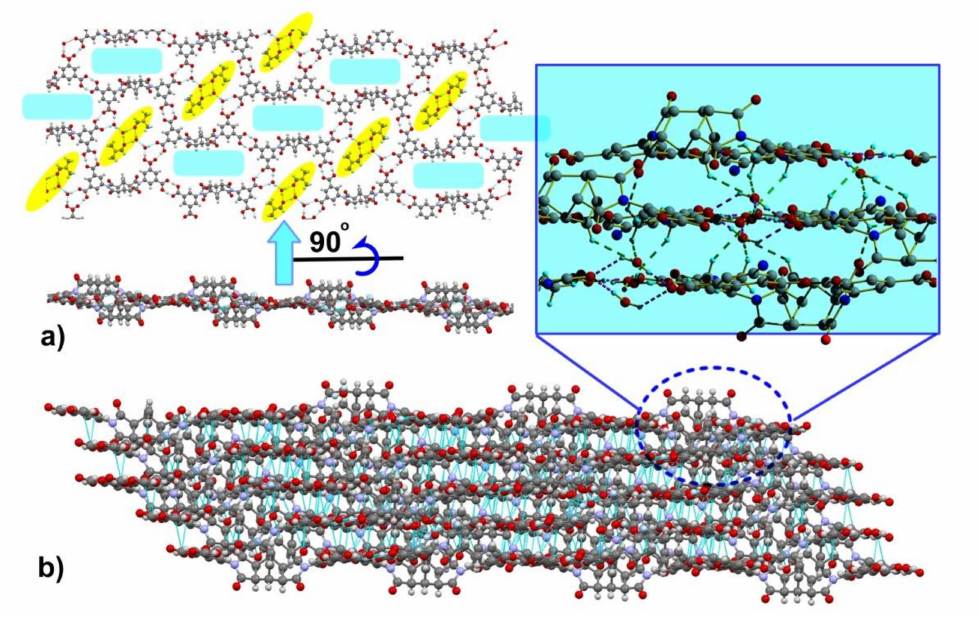
Figure 2. The top and side views of the two-dimensional hydrogen bond layer ( a ); the off-set packing of the two-dimensional hydrogen bonded sheets and interactions between adjacent layers ( b ) in 1-L